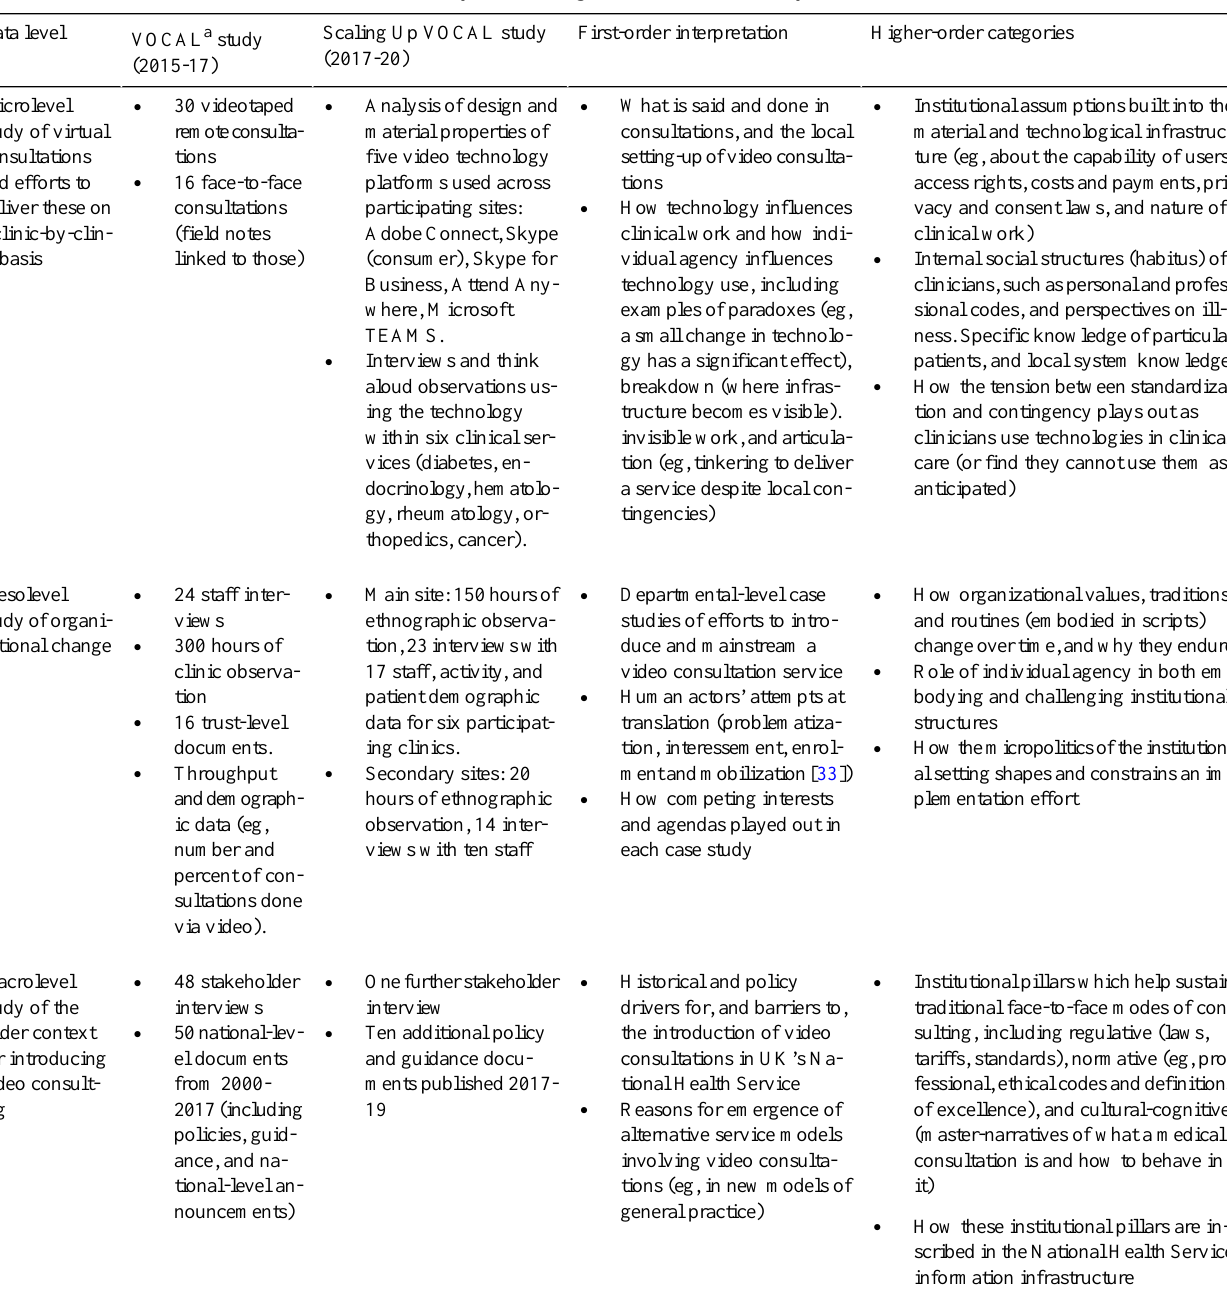
Table 1. Overview of multi-level data collection and analysis (including the earlier VOCAL